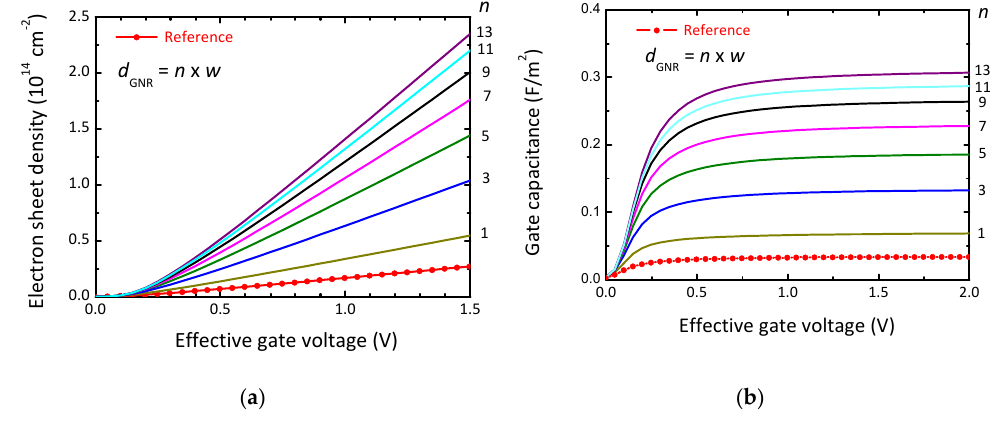
Figure 7. ( a ) Electron sheet density and ( b ) gate capacitance of multiple-channel GNR MOS structures with interribbon gates as a function of the effective gate voltage for different separations d GNR between adjacent GNRs (lines). The sheet density and the gate capacitance obtained for the single-channel GNR MOS structure without interribbon gate are also shown (red lines with symbols, designated as Reference).